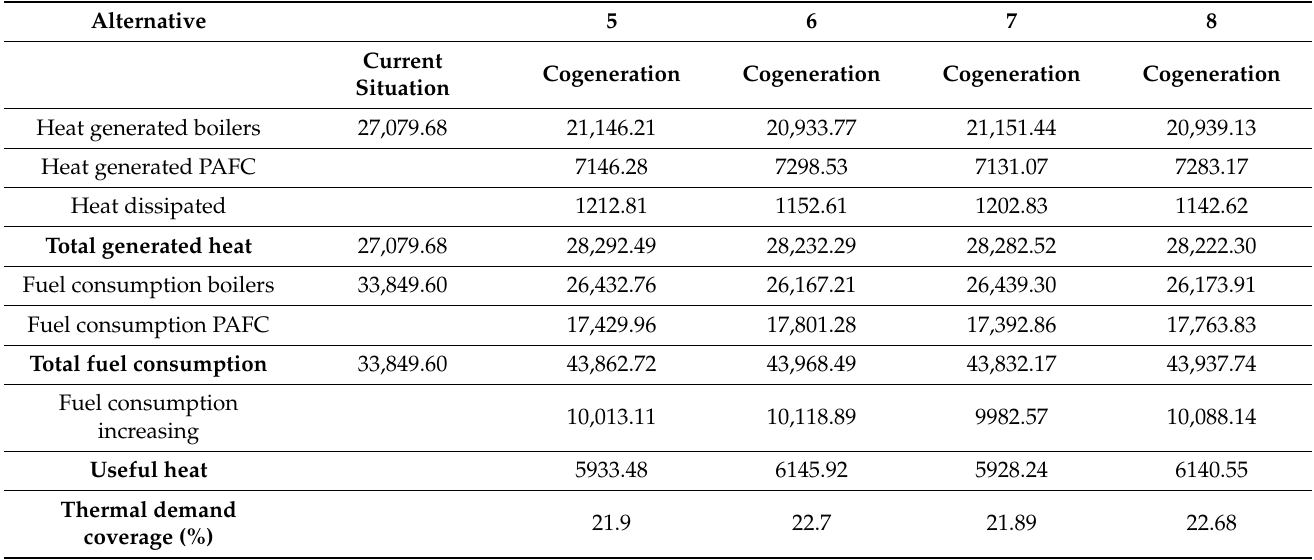
Table A4. Thermal Energy Balance (MWh/year) for alternatives considering 1 MW fuel cell power.